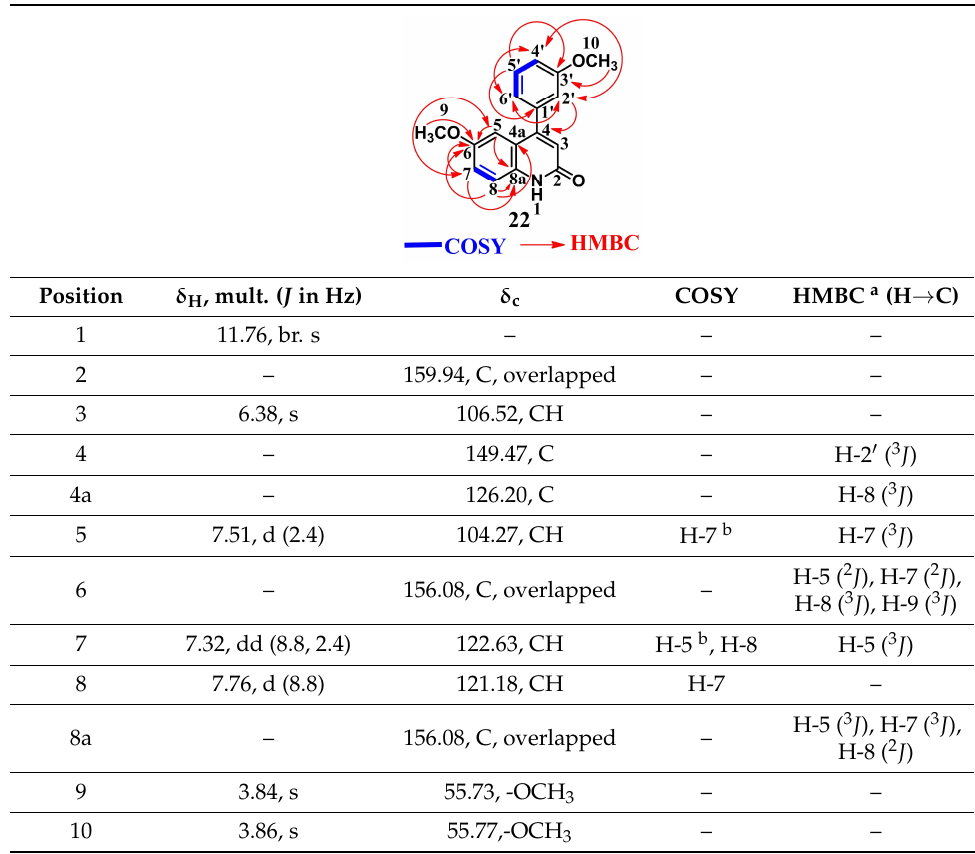
Table 1. 1 H and 13 C NMR spectroscopic ( δ /ppm), COSY, and HMBC data of compound 6-methoxy-